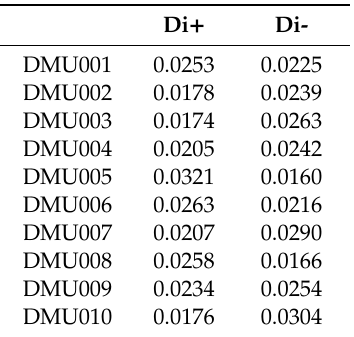
Table 6. PIS and NIS value from TOPSIS